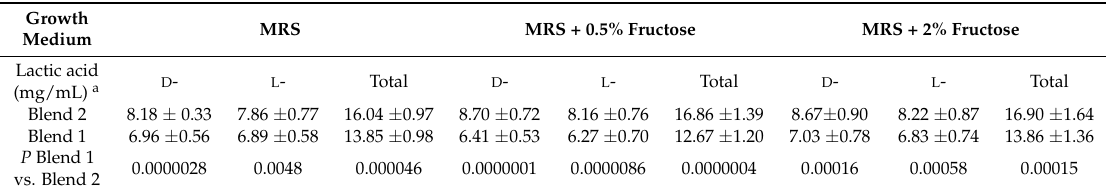
Table 1. Lactic acid production by probiotic blend grown in different growth medium. Blend 1 represents VSL#3 and Blend 2 represents